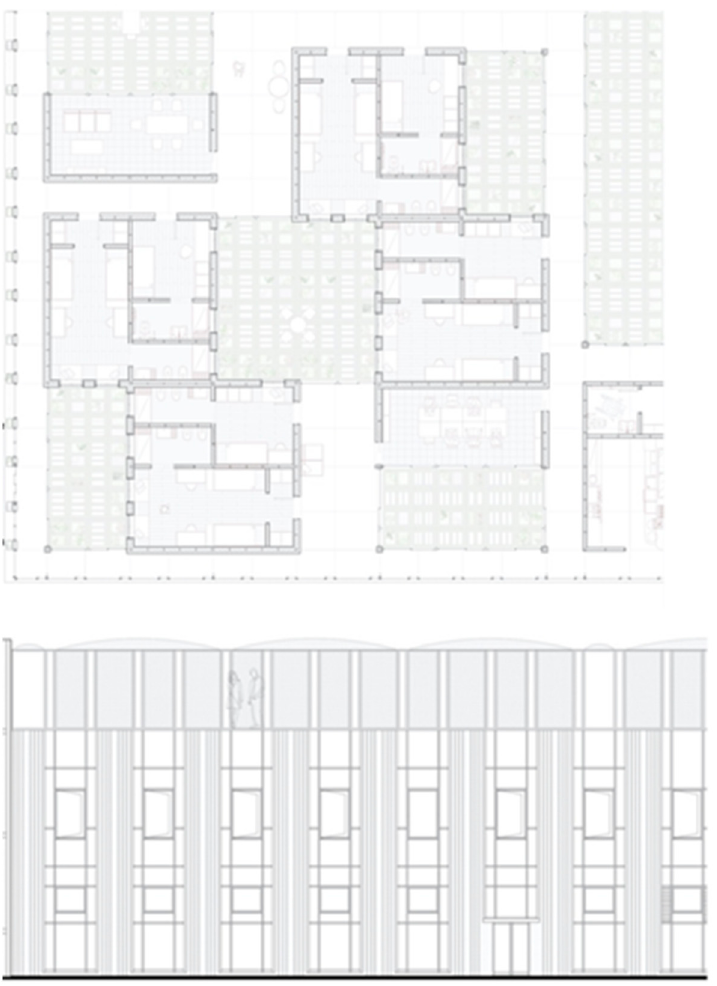
Figure 3. Architectural drawings of the front and floor plan of a single unit of the building. In the plan, the relationship between the living boxes (students’ rooms with bathrooms and common rooms; shown in gray) and the house for plants (openable–closable courtyards hosting the pallet containers for plants; shown in green) is shown in detail [12].